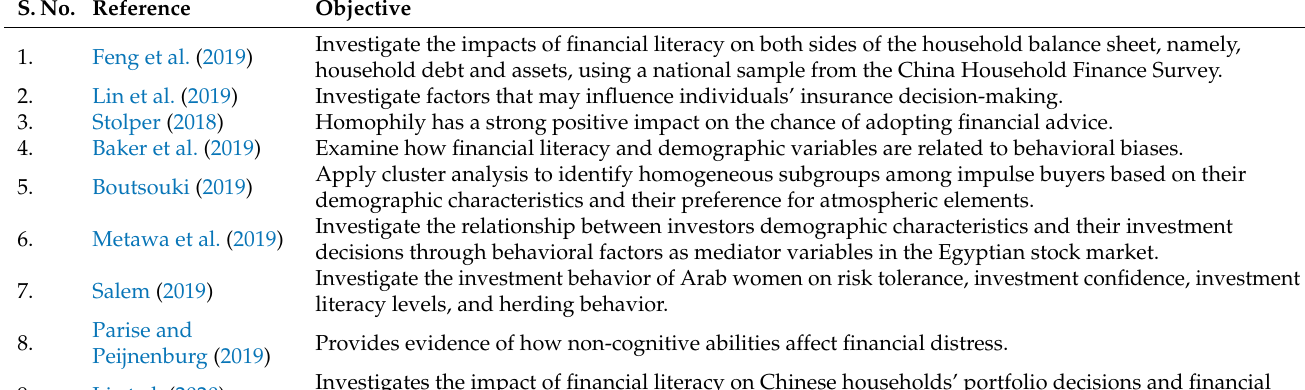
Table 4. Recent research trends and hottest topics in financial literacy during 2019 and